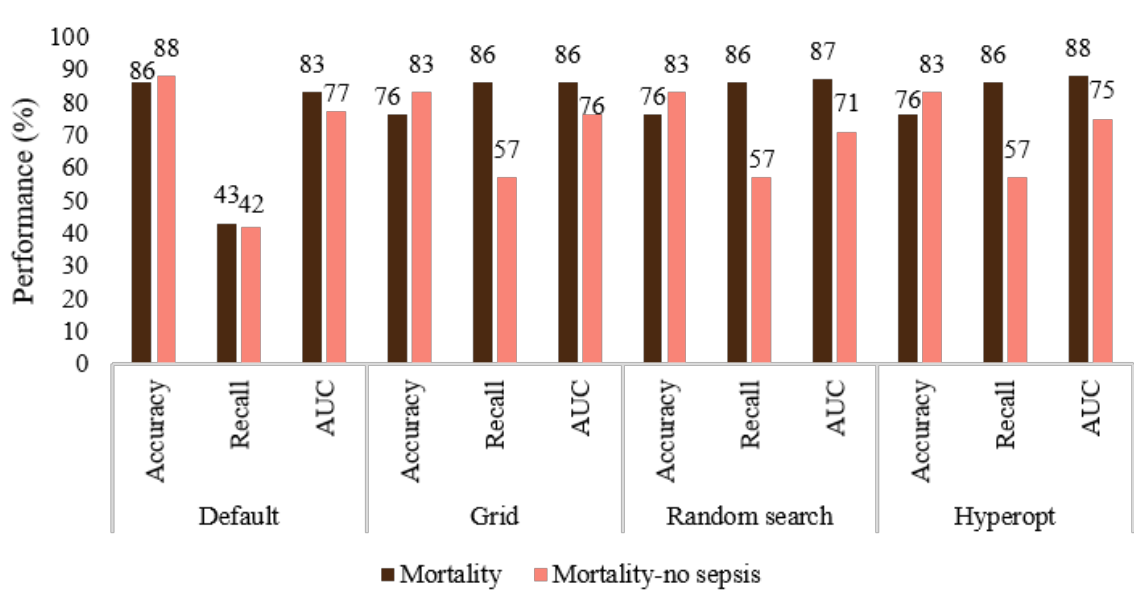
Figure 9. Comparing the performance of the default, grid search, random search, and Bayesian optimization (hyperopt) models when the predictive variable sepsis is removed from the feature set to predict